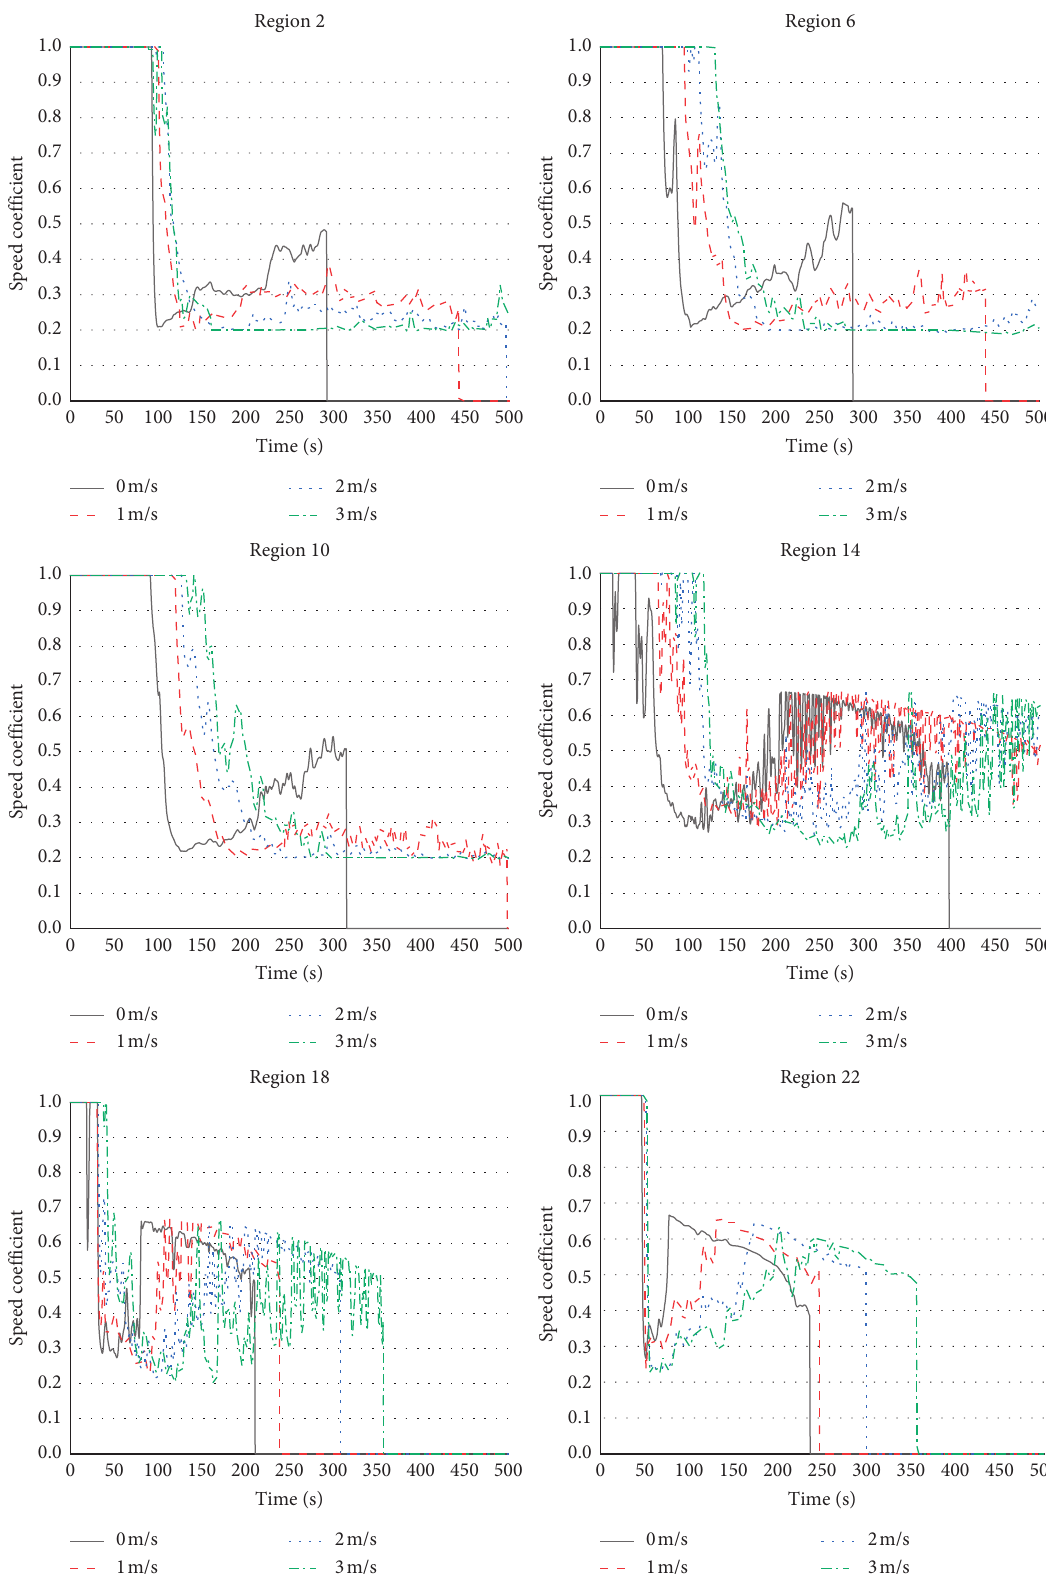
Figure 12: Effect of smoke exhaust rate on speed